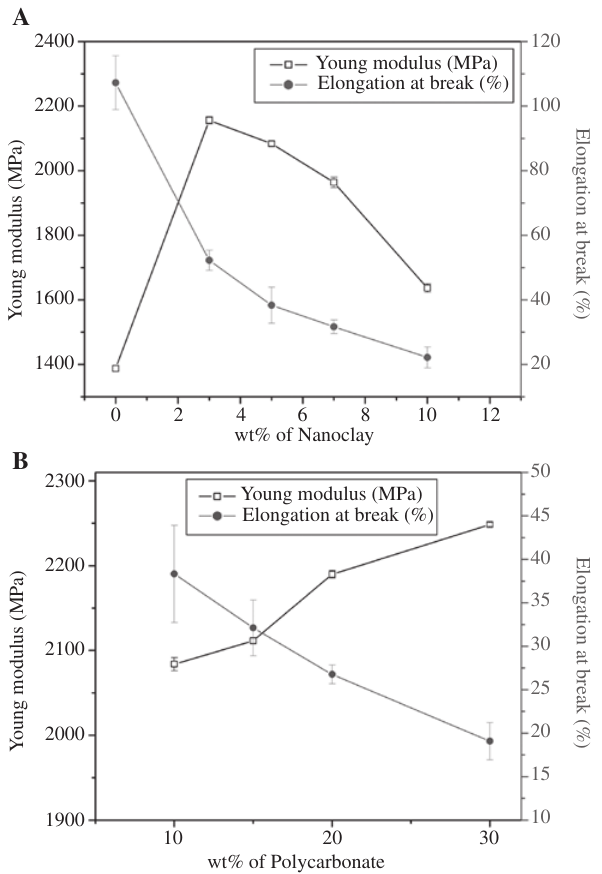
Figure 8: Young’s modulus and elongation at break of PP/PC nano- composites: (A) Effect of NC content, (B) effect of PC